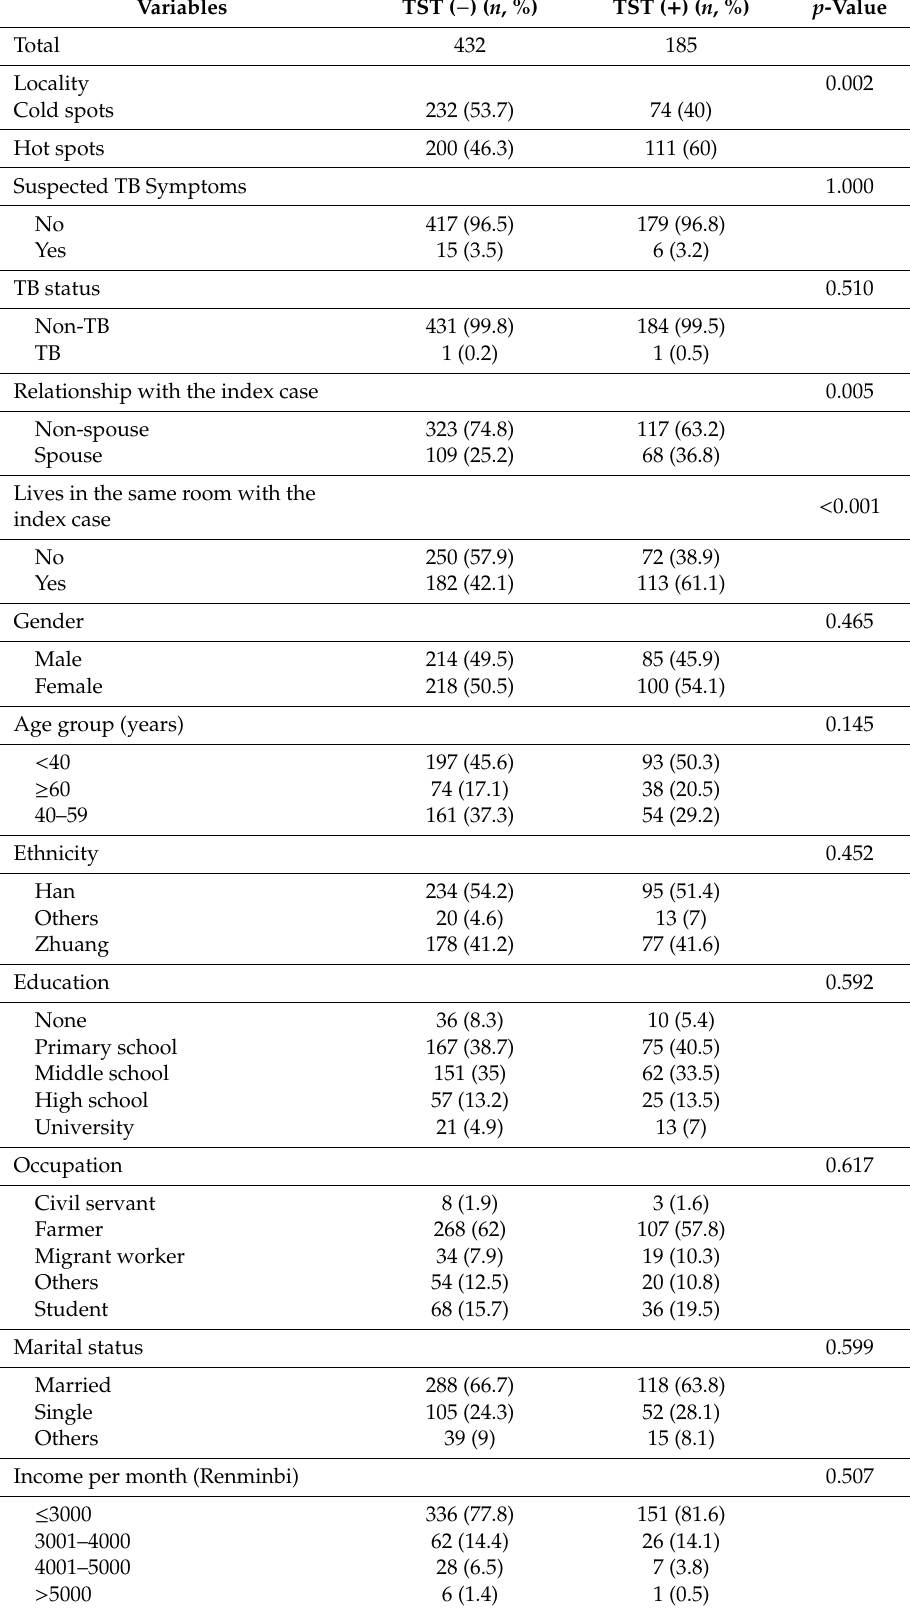
Table 4. Univariate analysis of factors associated with TST status among TB household